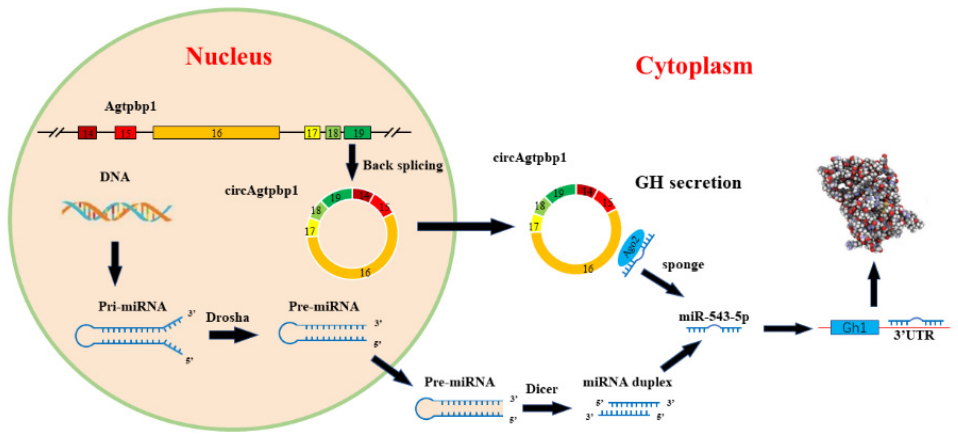
Figure 7. The schematic diagram shows the mechanism underlying circAgtpbp1 as a ceRNA for miR-543-5p.